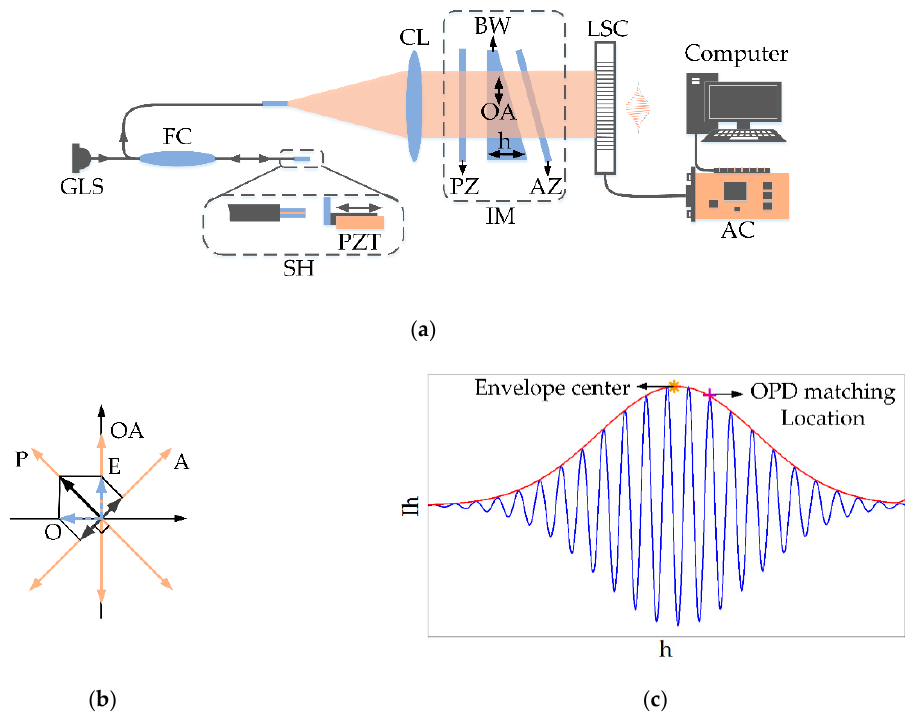
Figure 2. Polarized low-coherence interferometry (PLCI) demodulation system: ( a ) structure diagram; ( b ) geometrical relationship of the components in interference module (IM); ( c ) theoretical distribution of interference fringe.